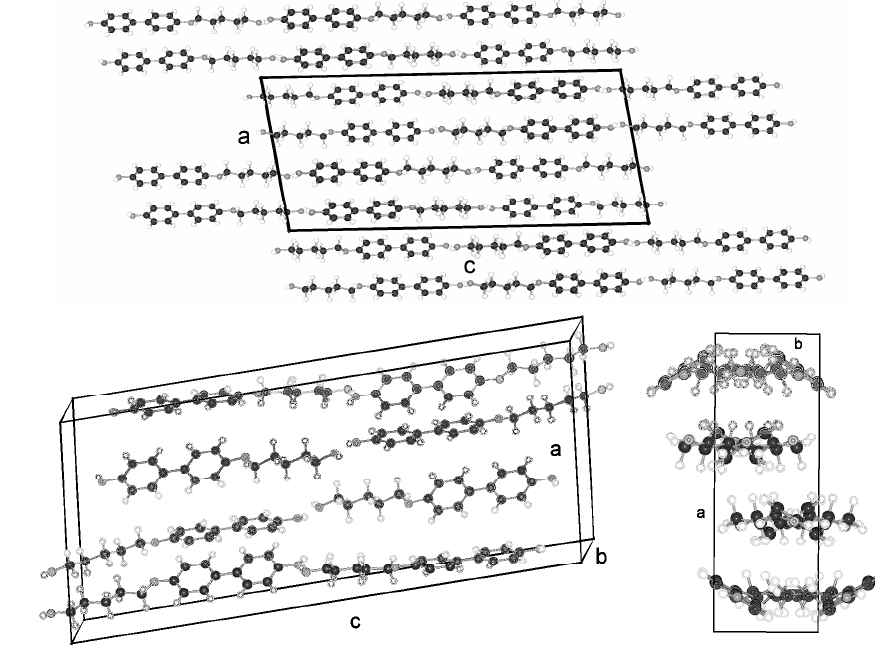
Figure 4. Antiparallel arrangement of the molecules of H5HBP in the centrosymmetric /c projected along [010], inclined to a small extent from this projection and space group P2 1 along [001] shown at the bottom right